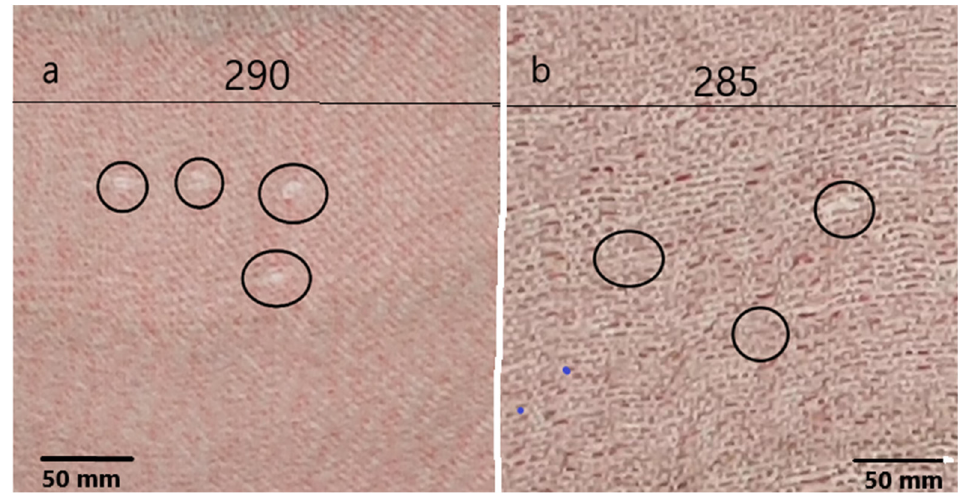
Figure 14. Fabric penetration during energy absorption test. ( a ) Twill fabric, and ( b ) matt fabric. Table 5. Energy absorbed by matt and twill